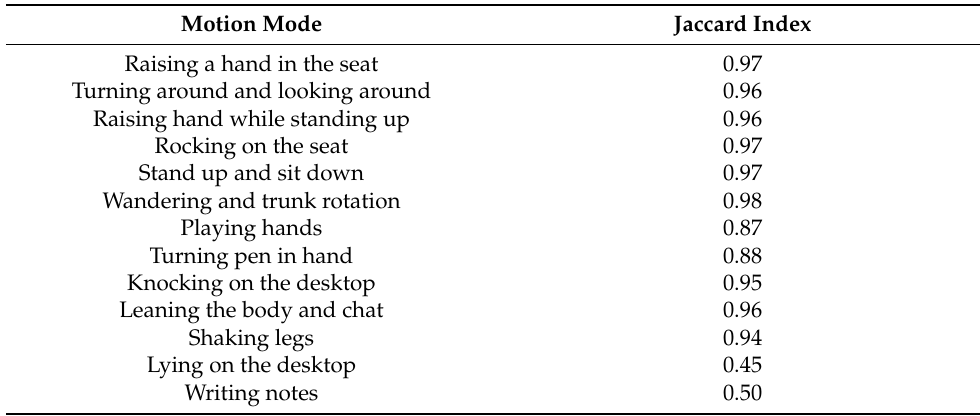
Table 2. Jaccard index for 13 motions. All the extracted valid segments’ indices except lying on the desktop and writing notes are more than 88% similar to the